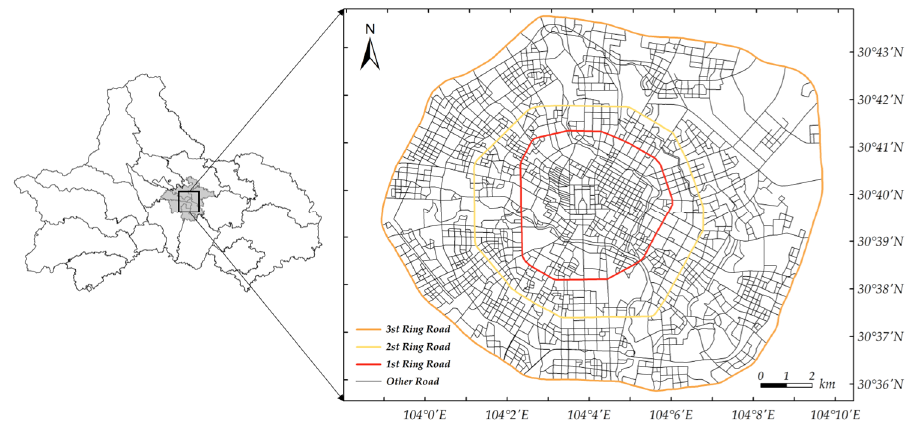
Figure 1. Study area of Chengdu, China.